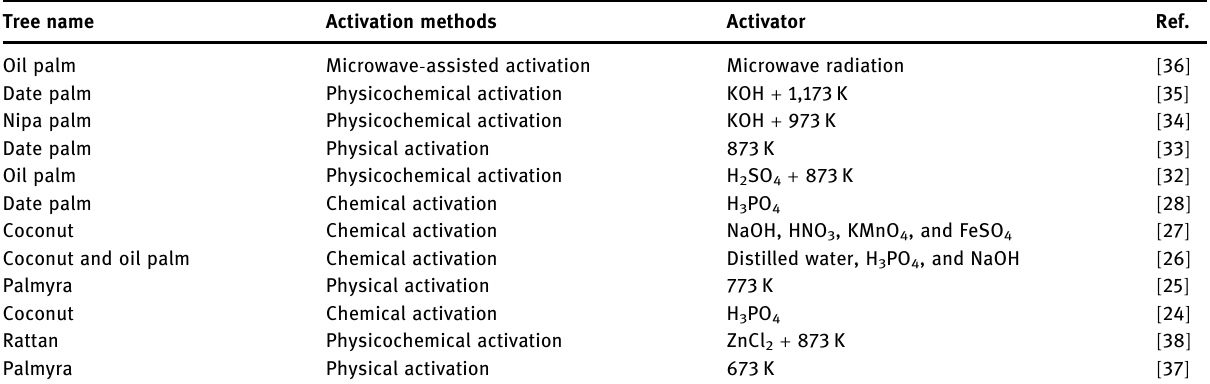
Table 2 : Method for synthesizing AC from the Arecaceae family Tree